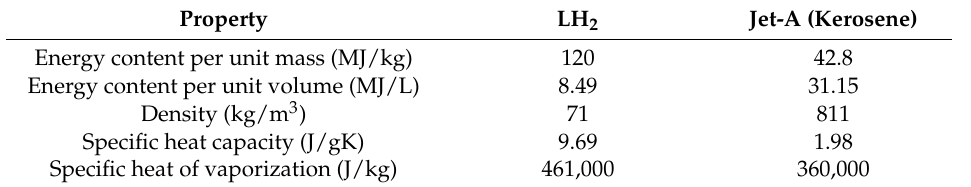
Table 1. LH 2 properties compared to Jet-A (kerosene) fuel [4–6]. Property LH 2 Jet-A (Kerosene) Energy content per unit mass (MJ/kg) 120 42.8 Energy content per unit volume (MJ/L) 8.49 31.15 Density (kg/m 3 ) 71 811 Specific heat capacity (J/gK) 9.69 1.98 Specific heat of vaporization (J/kg) 461,000